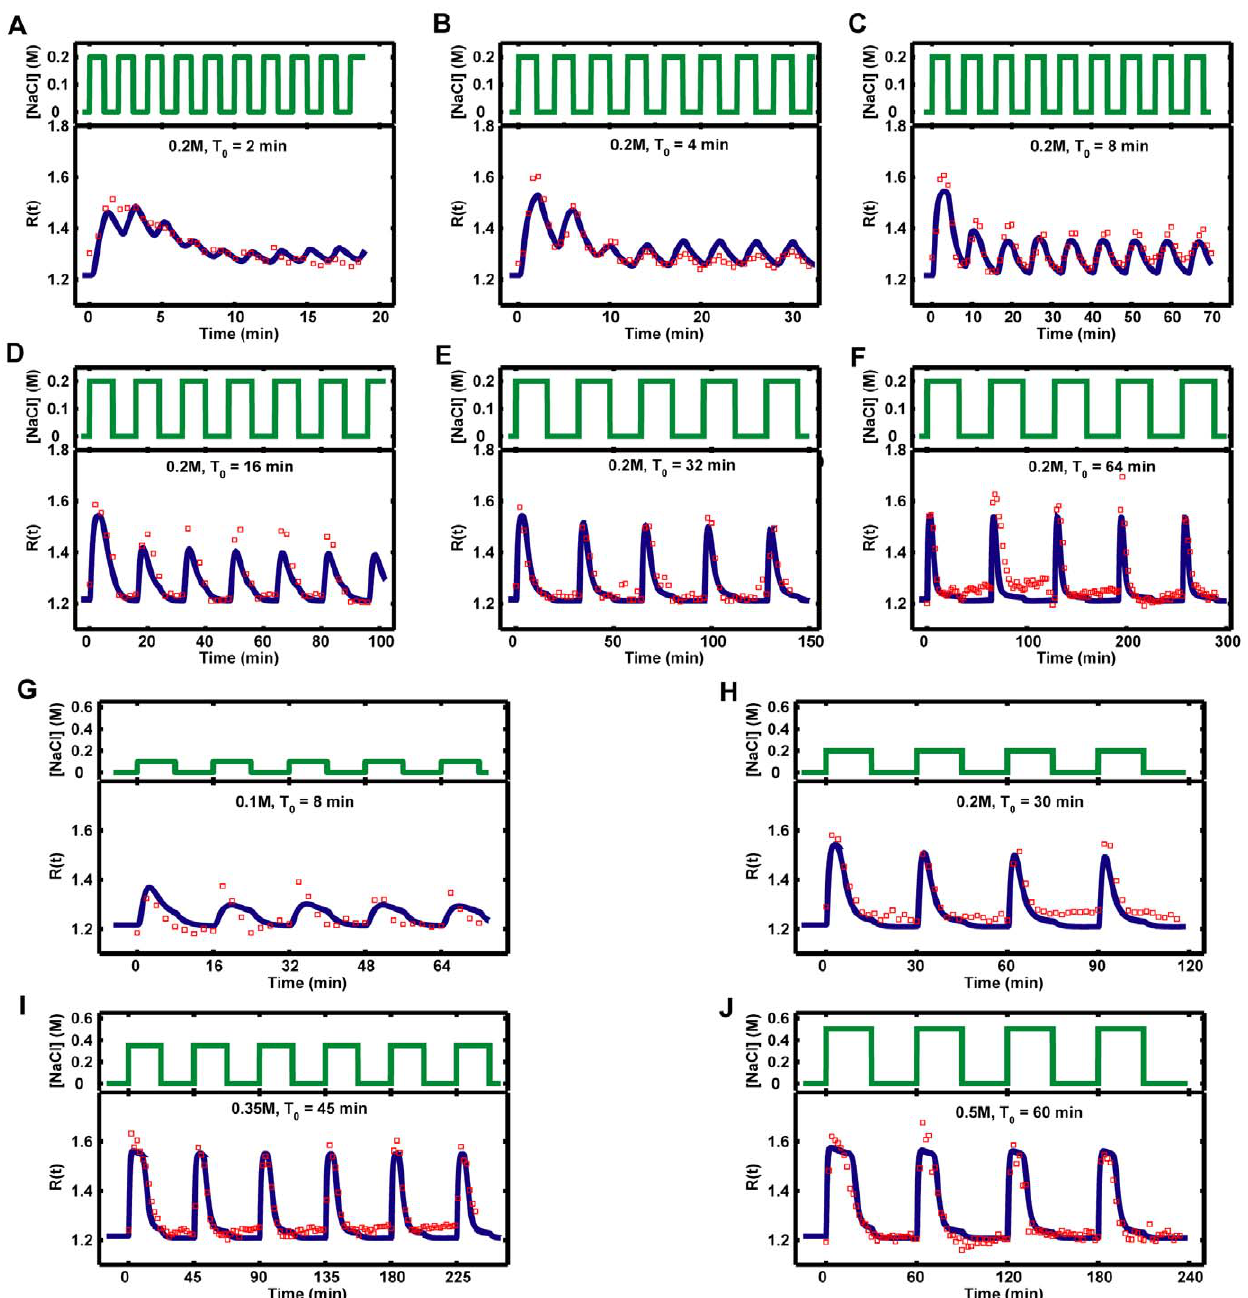
Figure 3. Comparison of model fits to the experimental data sets for periodic square pulses of osmolarity. Red squares represent the experimental data sets from Fig. S2 ( A–F ) and Fig. S5 ( G–J ) in reference [10]. Blue curves are the simulation result from our model in this study. T 0 is the period of periodic square pulses. In all cases, the time of the pulse in on phase and off phase are equal to half of T 0 (T on =T off =T 0 /2). doi:10.1371/journal.pone.0009522.g003 pulses (Figure S6). Similar as the model analysis for Hog1 response to a single pulse of stress change, the signal transduction efficiency for the integral of the Hog1 phosphorylation is also optimized to a frequency of periodic stress change (with period of about 1 min).